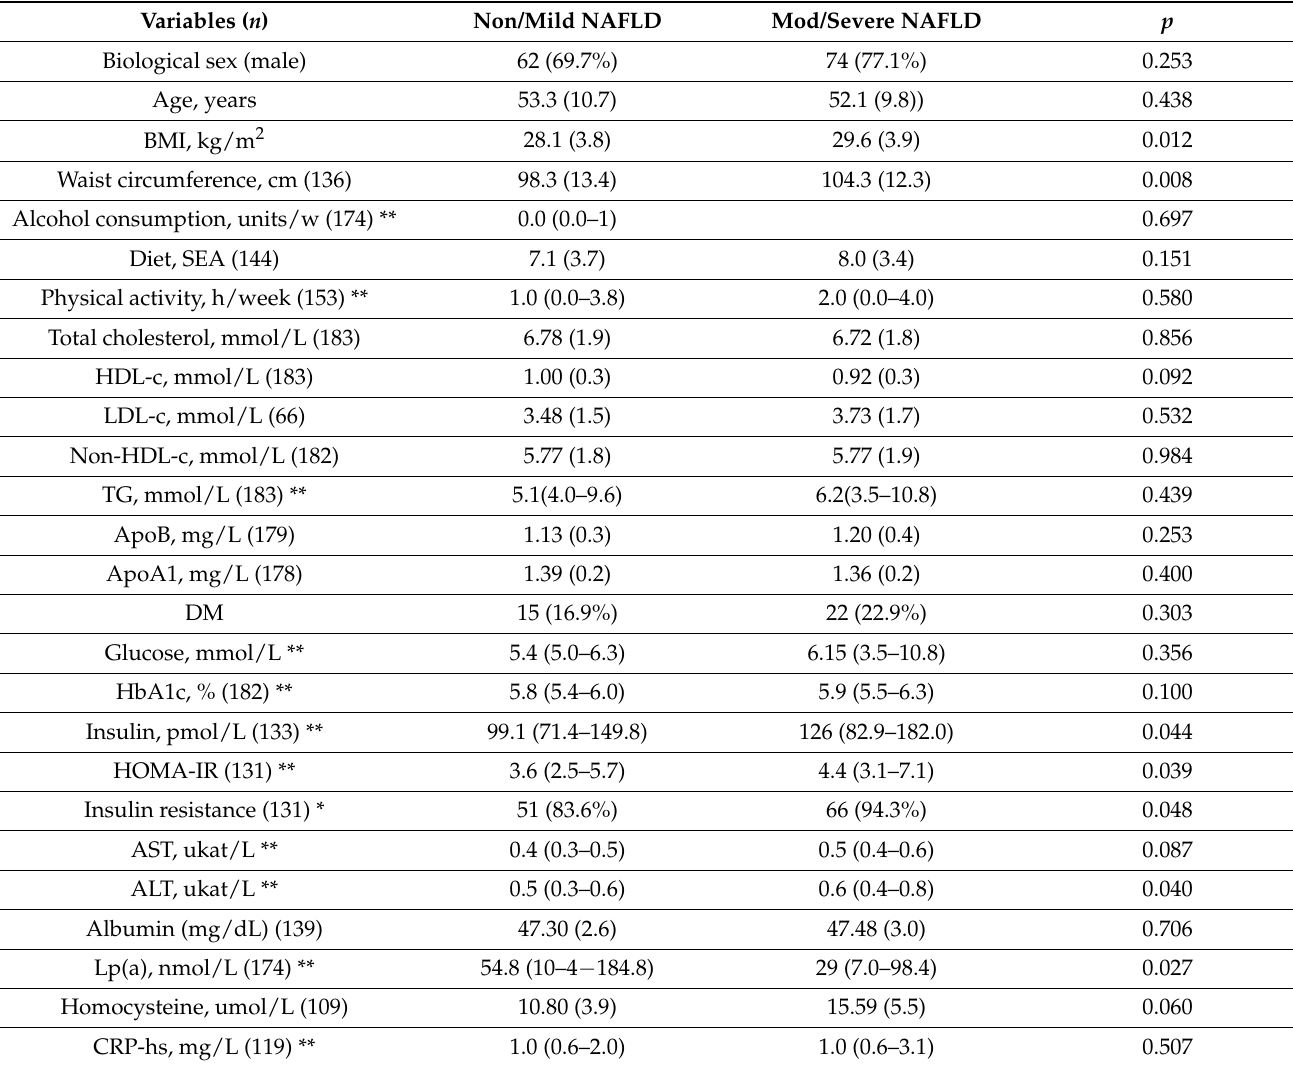
Table 1. Clinical and metabolic characteristics of the study